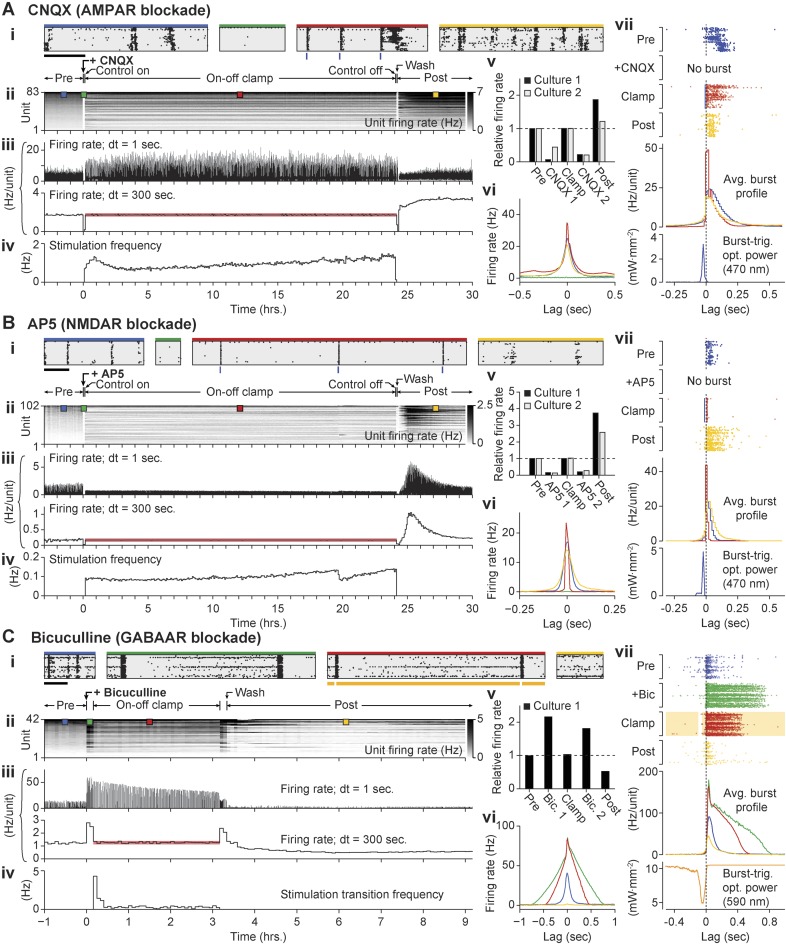
Decoupling spiking and neurotransmission using on-off feedback control.(A) Summary of a 24-hr AMPAergic neuortransmission/spiking decoupling protocol. (A.i) Rastergrams show zoomed portions of spiking activity taken from discrete times during the experiment. Top color bars indicates recording epoch. Blue bars beneath indicate stimulus times. Horizontal scale bar, 1 s (A.ii) Firing rate histogram for the duration of the 33-hr recording for each unit, using 5-min bins. Firing levels are indicated by the grey-scale to the right. CNQX (AMPAergic receptor antagonist) was added at time 0 and removed 24 hr and 10 min later. Closed-loop stimulation began 5 min after CNQX addition and lasted 24 hr. Colored boxes indicate the location of the data used in the zoomed rastergrams, crosscorrelograms, and burst profiles. (A.iii) The average unit firing rate using 1-s bins and 5-min bins. The red line indicates the target rate. (A.iv) Closed-loop stimulation frequency. (A.v) Time- and unit-averaged firing rates for each epoch, normalized to the pre-drug firing level. The ‘post’ firing rate was evaluated over 6 hr following the drug wash. (A.vi) The average unit to unit crosscorrelogram for each control epoch. (A.vii) Example burst ratergrams, average burst profiles, and burst-triggered stimulus optical intensity for each control epoch. The location of the data used to calculate (A.vi) and (A.vii) is indicated by the matching colored boxes in (A.ii). (B, C) Same as (A) but using AP5 (B) or bicuculline (C) to block NMDAergic and GABAergic neurotransmission, respectively. For bicuculline, the firing rate was clamped over a 3 hr period. The changes in spontaneous firing levels before on-off control for each culture were: CNQX, −93.8 and −56.3%; AP5, −87.3 and −84.5%; bicuculline, +116.2%, and upon relief from on-off control: CNQX, −78.7 and −80.0%; AP5, −73.0 and −80.4%; bicuculline: +81.3%.